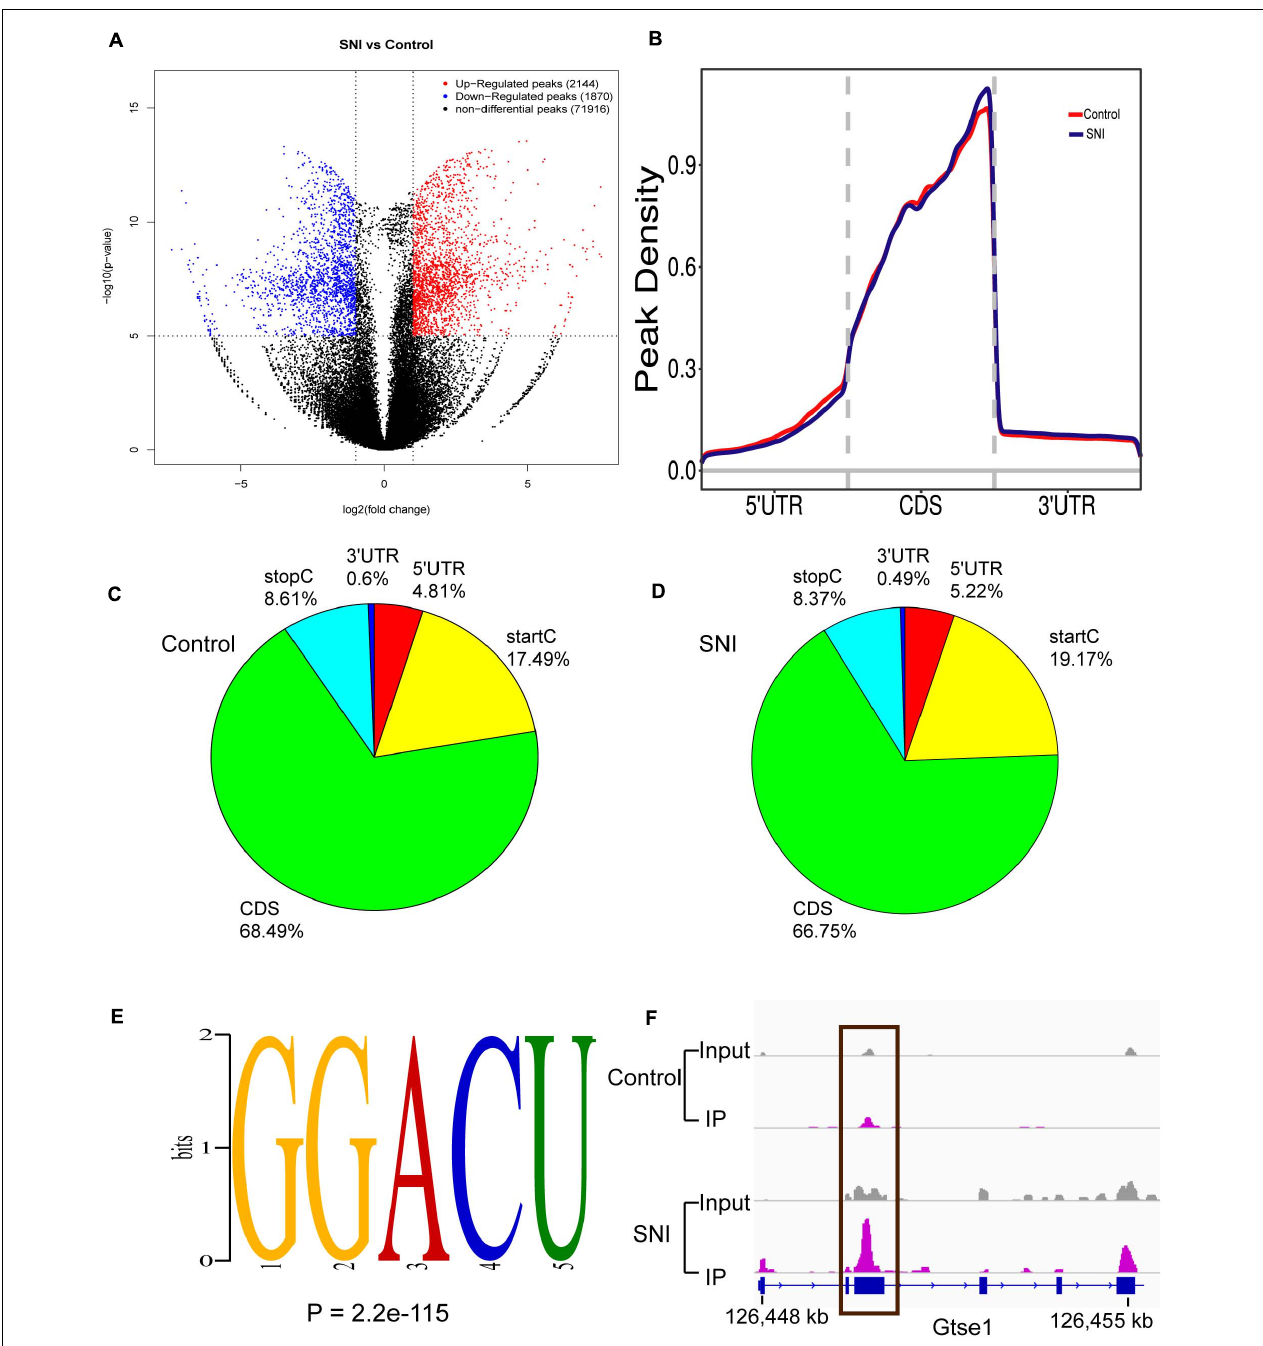
FIGURE 2 | The degree and pattern of m6A modification peaks in SNI and control groups. (A) Volcano plots indicating the distribution of differential m6A peaks after SNI. Fold-change ≥ 2.0, p < 0.00001, n = 3, via Fisher’s exact test. (B) Priority region and average distribution of m6A peaks. (C,D) The distribution of m6A peaks in SNI and control groups, respectively. (E) The top motifs enriched across differential m6A peaks. (F) Data visualization of the m6A-modified Gtse1 mRNA.